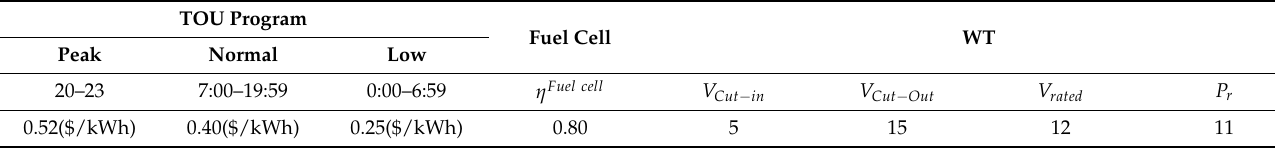
Table 2. TOU, WT, and fuel cell